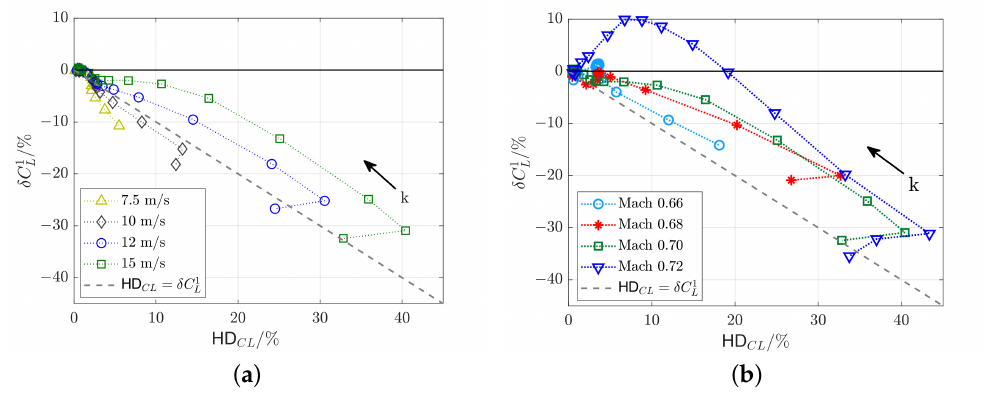
Figure 19. Harmonic deviation δ C 1 as a function of the harmonic distortion of the lift HD CL , which is L computed using 10 harmonics. ( a ) Mach 0.70, ( b ) (cid:98) W G = 15 m/s. For the relative maximum lift δ C Max plotted in Figure 20, similar trends are observed L